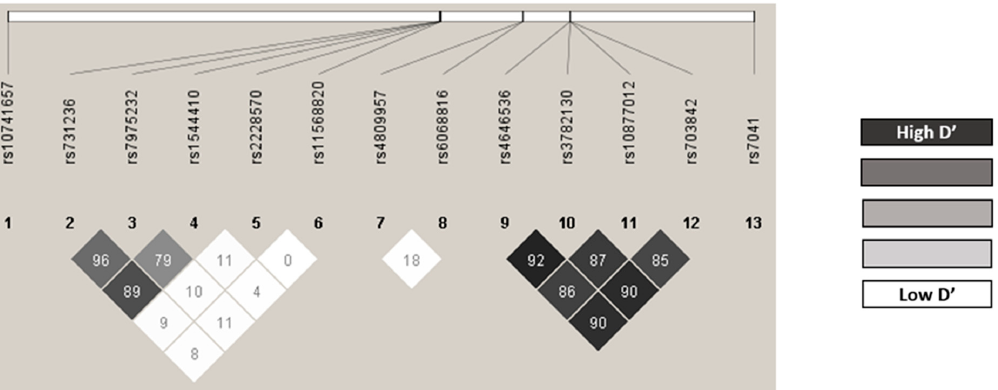
Figure 1. Linkage disequilibrium (LD). Polymorphisms with strong linkage disequilibrium are shown in darker shades and those with less linkage disequilibrium are shown in lighter shades.